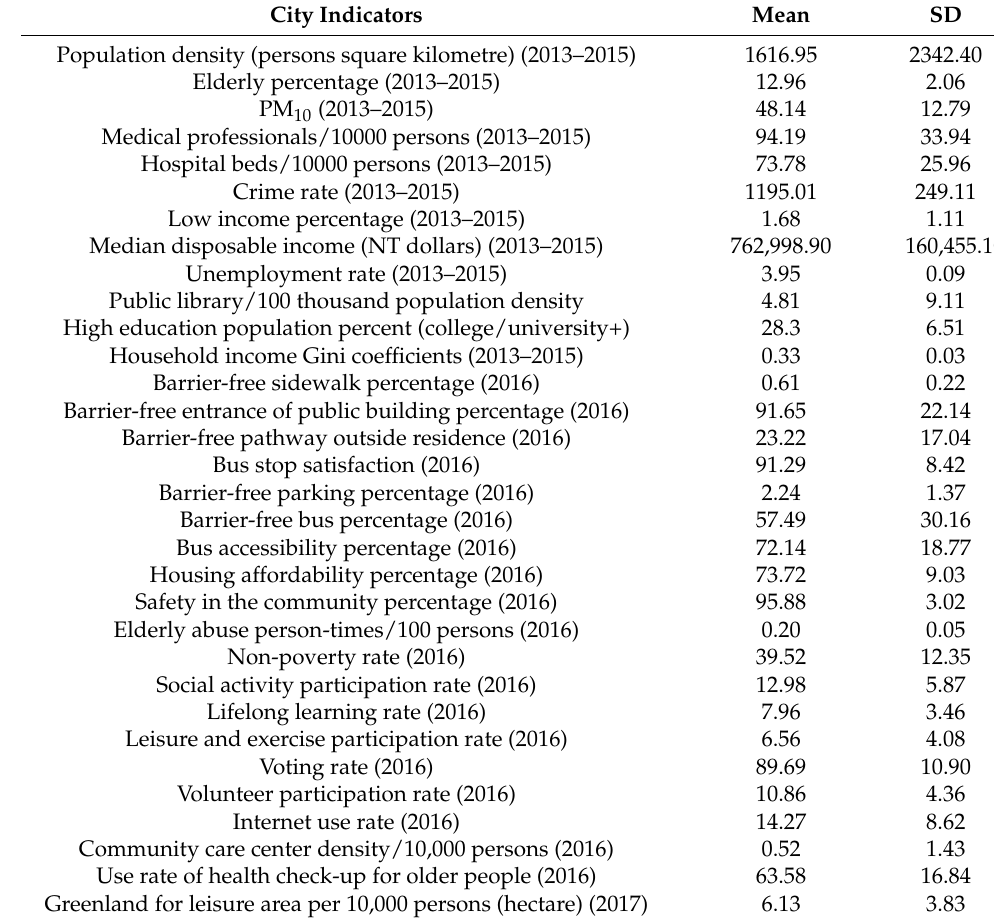
Table 2. Descriptive analysis of the city indicators ( n =